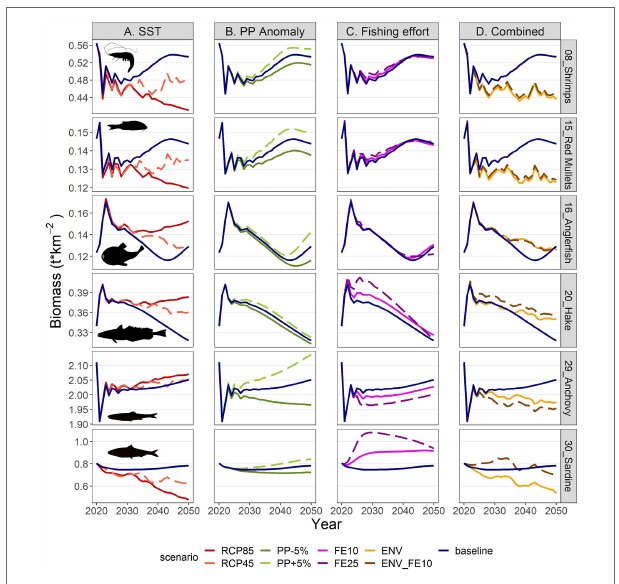
FIGURE 9 | Biomass projections for selected FGs in the period 2021-2050 under scenarios related to (A) SST, (B) PP Anomaly, (C) fishing effort and (D) combination of drivers. The description of the scenarios is provided in Table 2 .